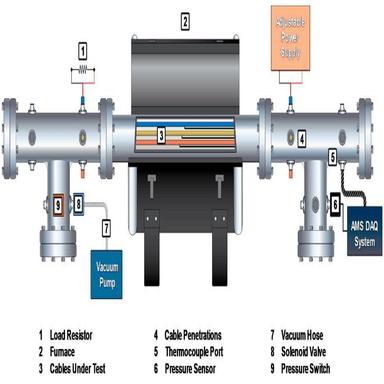
Diagram of the high-temperature vacuum chamber used to simulate the environment inside an SMR containment vessel.